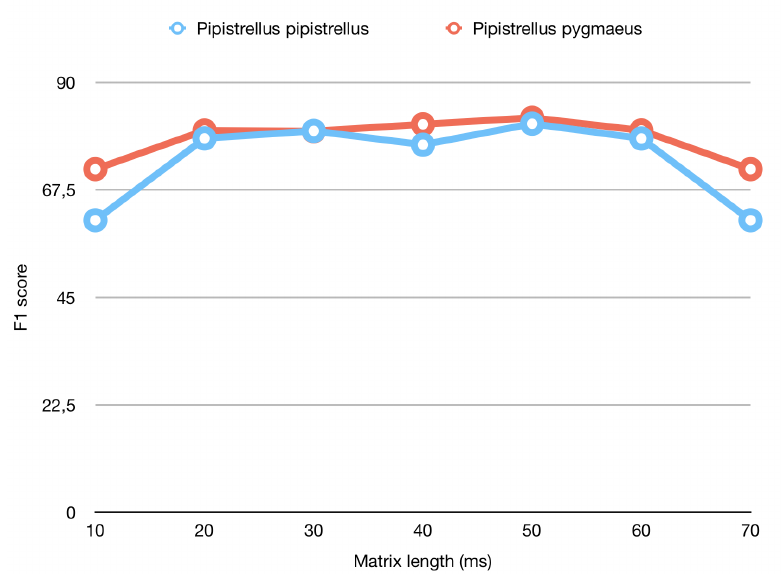
Figure 13. F1 score results of each matrix time length obtained with the spectrogram matrices parameterizations a Convolutional Neural Network